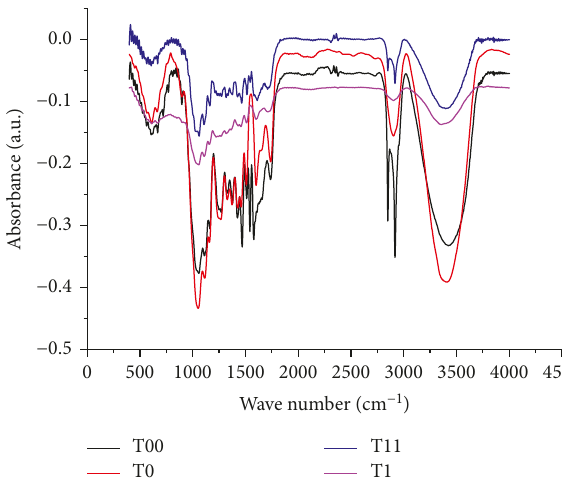
Figure 7: The FTIR spectra of specimens with the same initial 5% MC and various experimental conditions: (T1) heat treated at 220 ° C and fungal-infested, (T11) heat treated at 220 ° C and no fungal infestation, (T0) no heat treatment and no fungal infestation, and (T00) no heat treatment and fungal